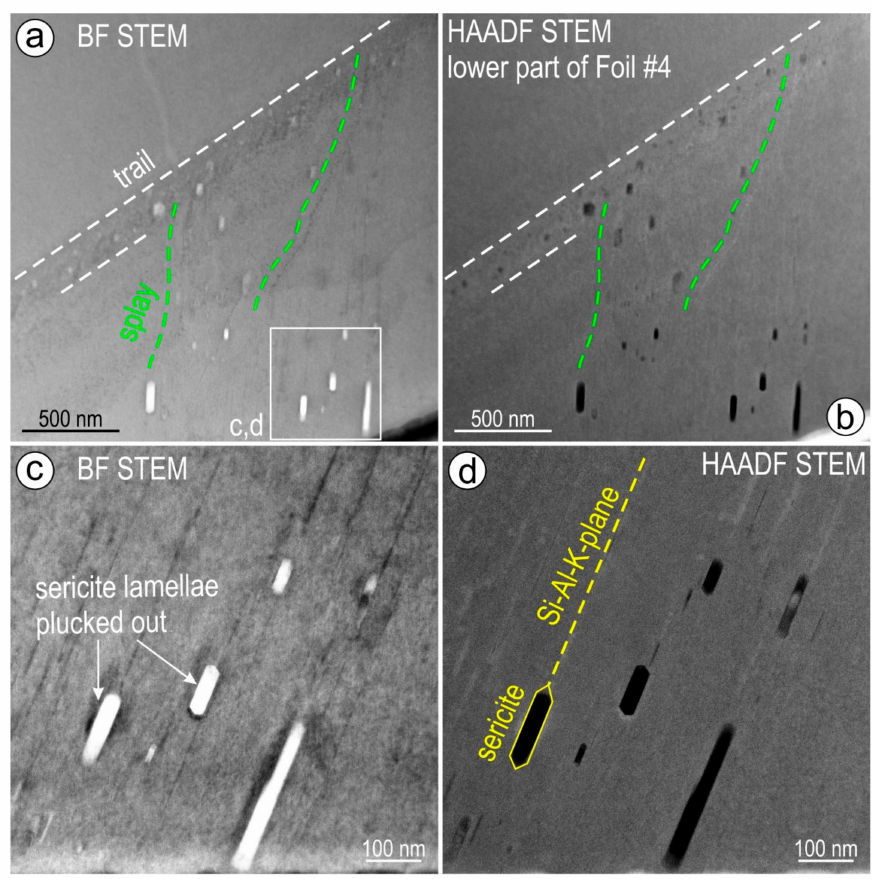
Figure 11. Images in BF and HAADF STEM modes as marked, showing aspects of hematite in the lower part of foil #4. ( a , b ) Trail of inclusions and cavities (white lines) with branching splays (green) towards fields of hexagonal platelets. ( c , d ) Detail of the platelets interpreted as sericite lamellae formed in continuation of Si-Al-K-planes.